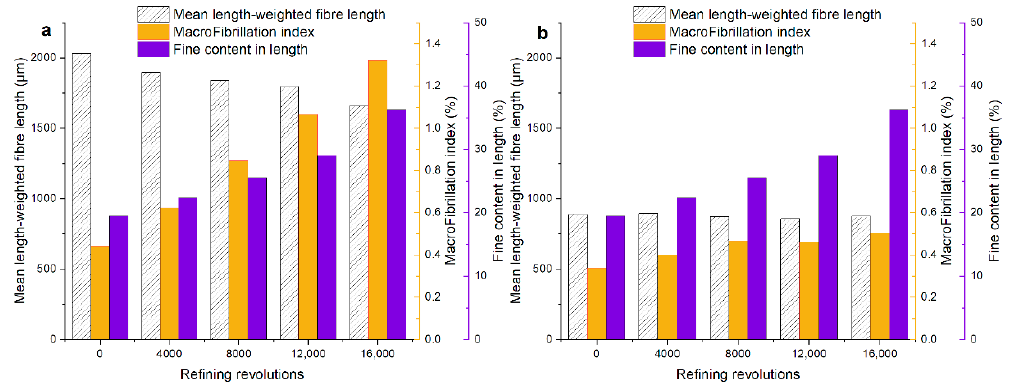
Figure 1. The morphological analysis for the unrefined and refined samples: ( a ) softwood fibers and ( b ) hardwood fibers.